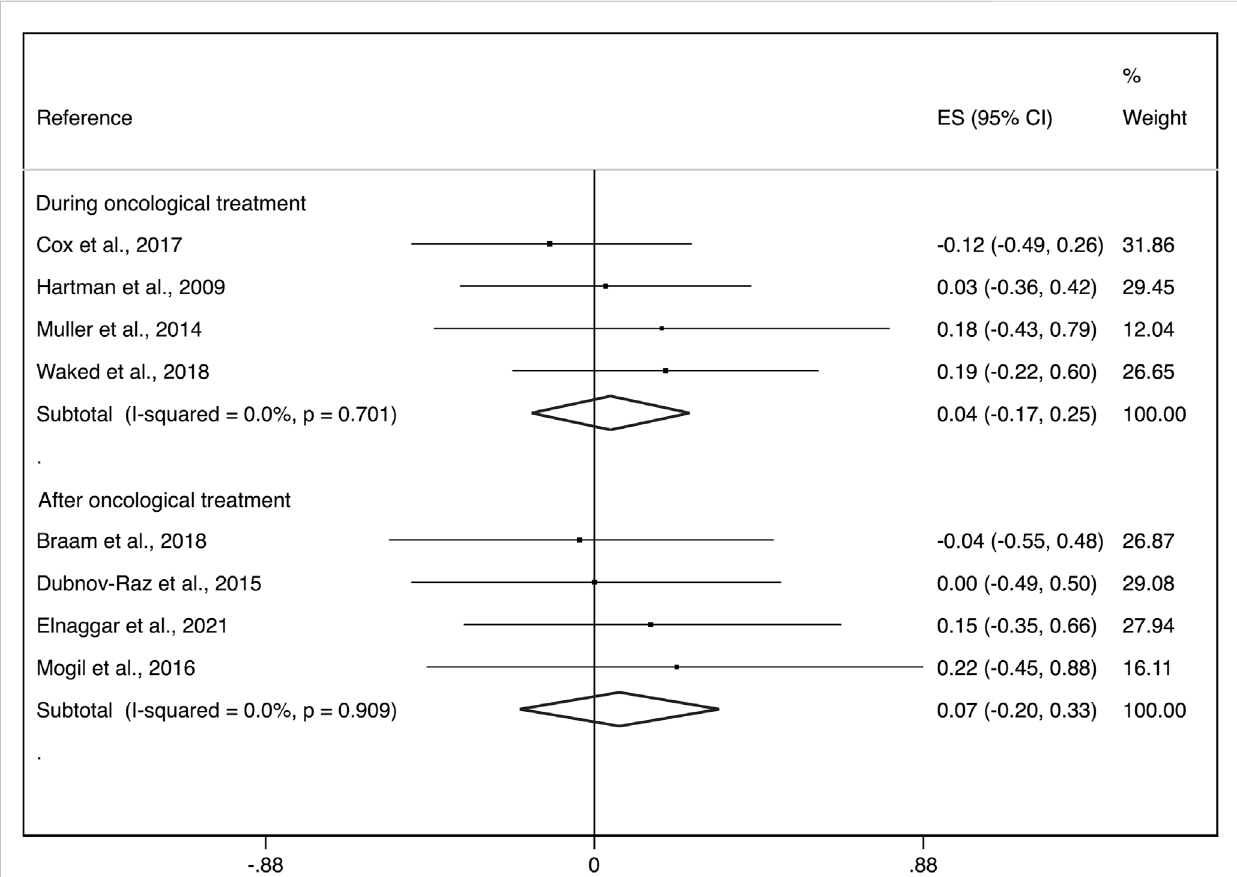
FIGURE 4 Forest plots of the effect size for the change in aBMD at the whole body, lumbar spine and femoral neck by groups (during cancer treatment and surviving patients). CI: con fi dence interval, ES: effect